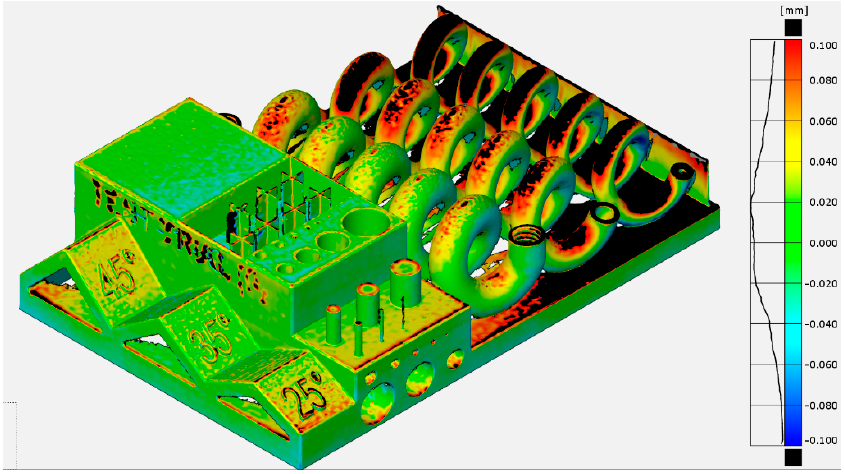
Figure 11. Color plot of the central spiral sample, first job from company H.